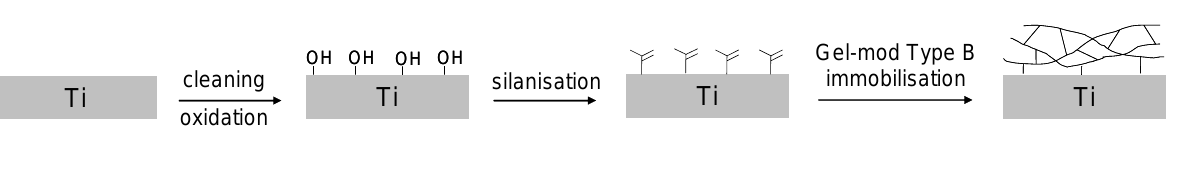
Figure 6. Overview of gelatin immobilization on commercially pure Ti (cp Ti).